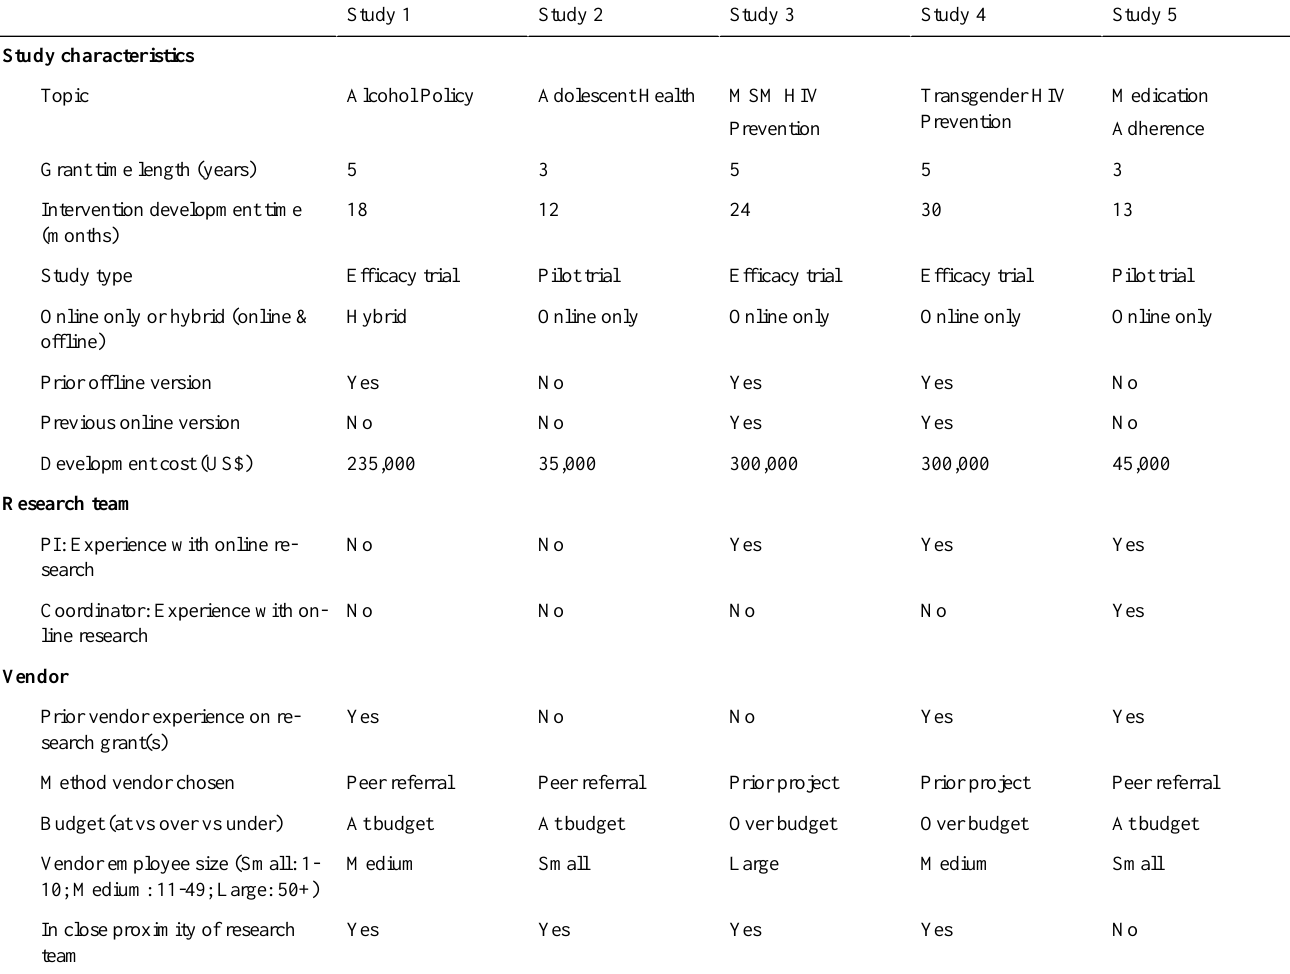
Table 1. Study, research team, and vendor characteristics.